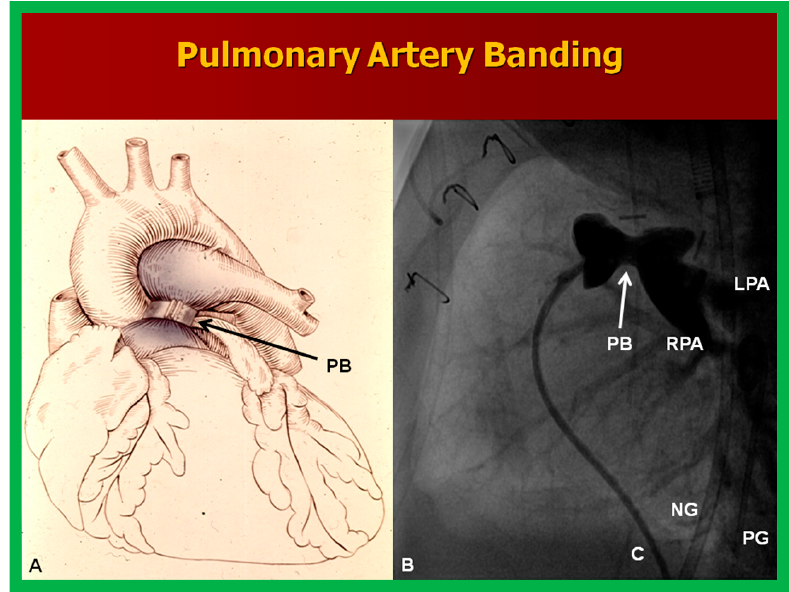
Figure 3. ( A ) A diagram illustrating pulmonary artery banding (PB) for patients with a severely increased blood flow into the pulmonary circuit and severe heart failure. ( B ) Cineangiographic image of the pulmonary artery angiogram in the lateral projection illustrating the narrowing of the pulmonary artery shown with an arrow in a baby who had surgical PB. Note: catheter (C); left pulmonary artery (LPA); nasogastric tube (NG); pigtail catheter (PG); and right pulmonary artery (RPA). Reproduced from [25].